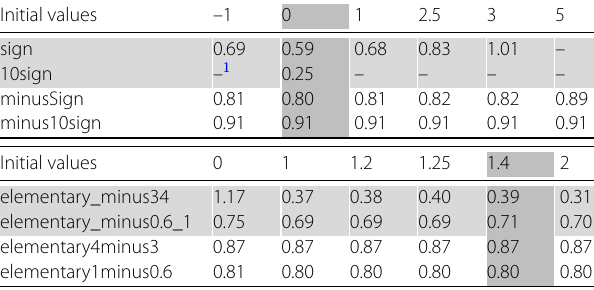
Table 2 Numerical Euler convergence rates Initial values –1 0